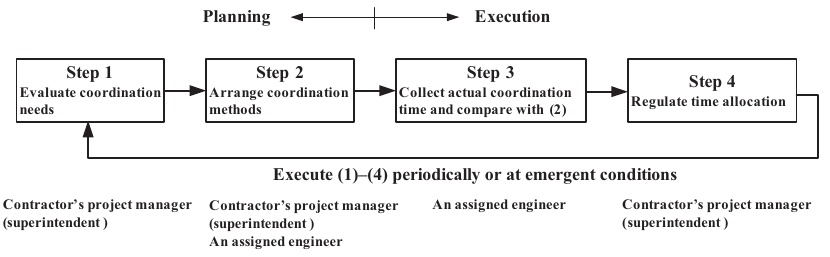
Fig. 3. Procedure for effective